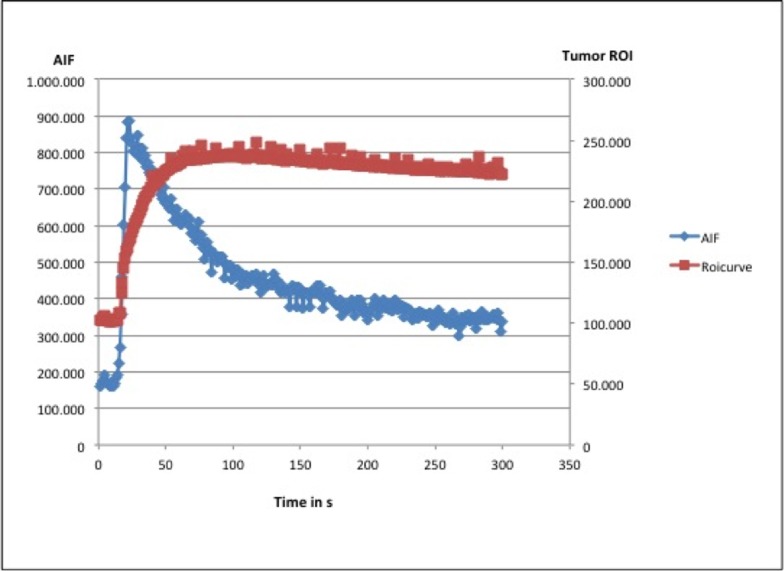
Representative signal-intensity vs. time curve for the assessment of contrast media kinetics in the tumor (red) and the inferior vena cava (blue).